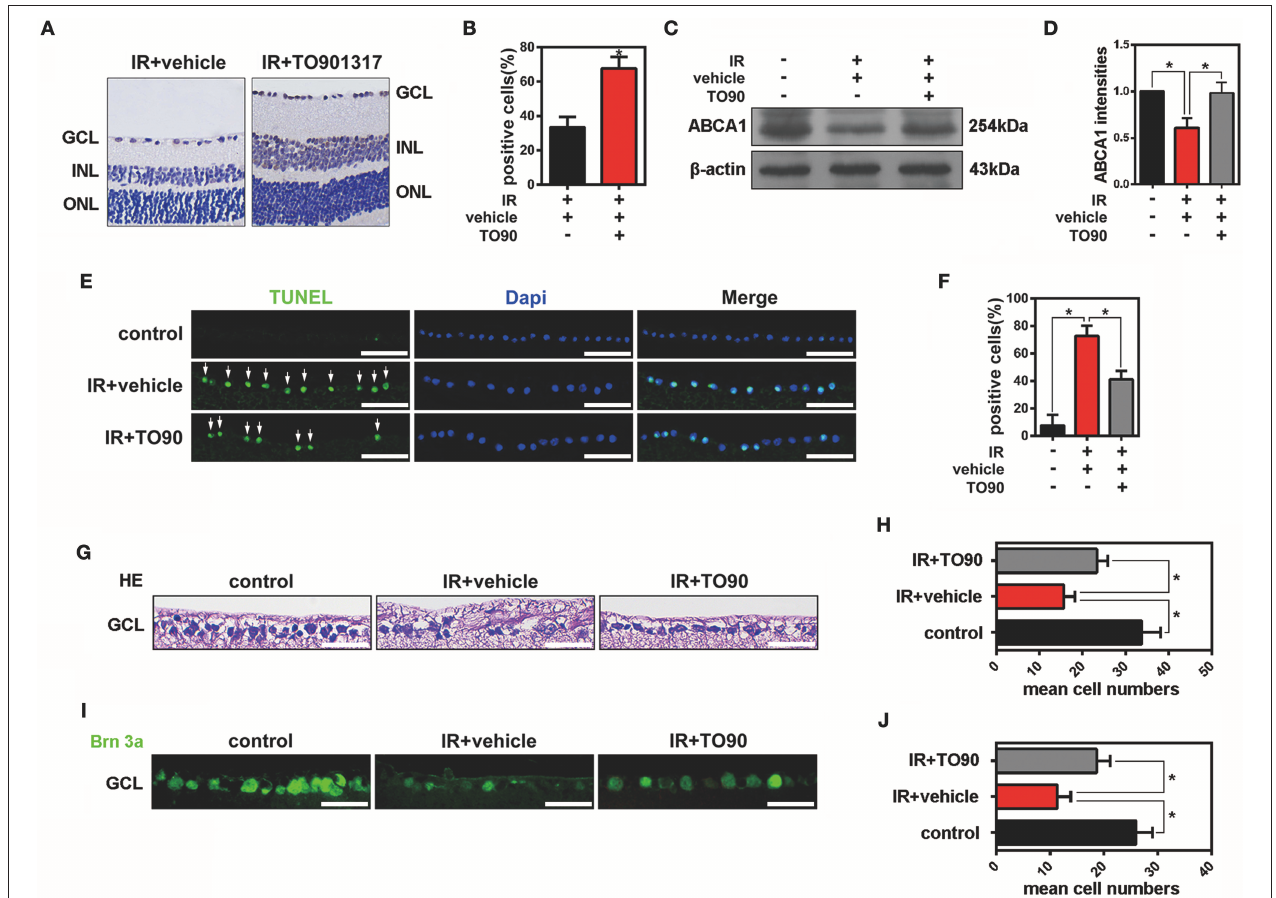
± S.D. ( n = 6 retinas per group). * P < 0.05, unpaired Student’s t test vs. IR + vehicle. (C) Western blot showing the expression of ABCA1 after IR with and without TO901317 pretreatment of the retina. (D) Statistical analysis of (C) . The data are presented as the mean ± S.D. ( n = 3 retinas per group). * P < 0.05, one-way